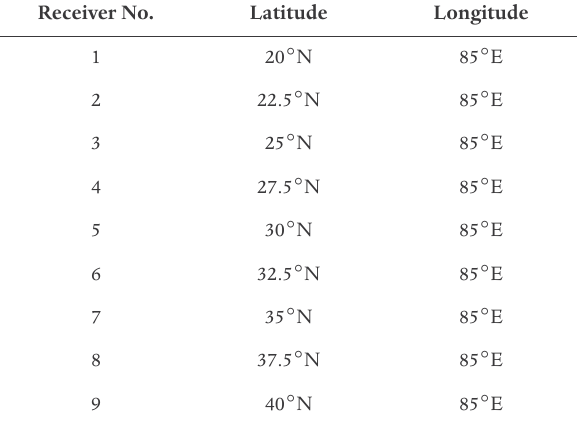
Table 2. Site information for 9 GPS